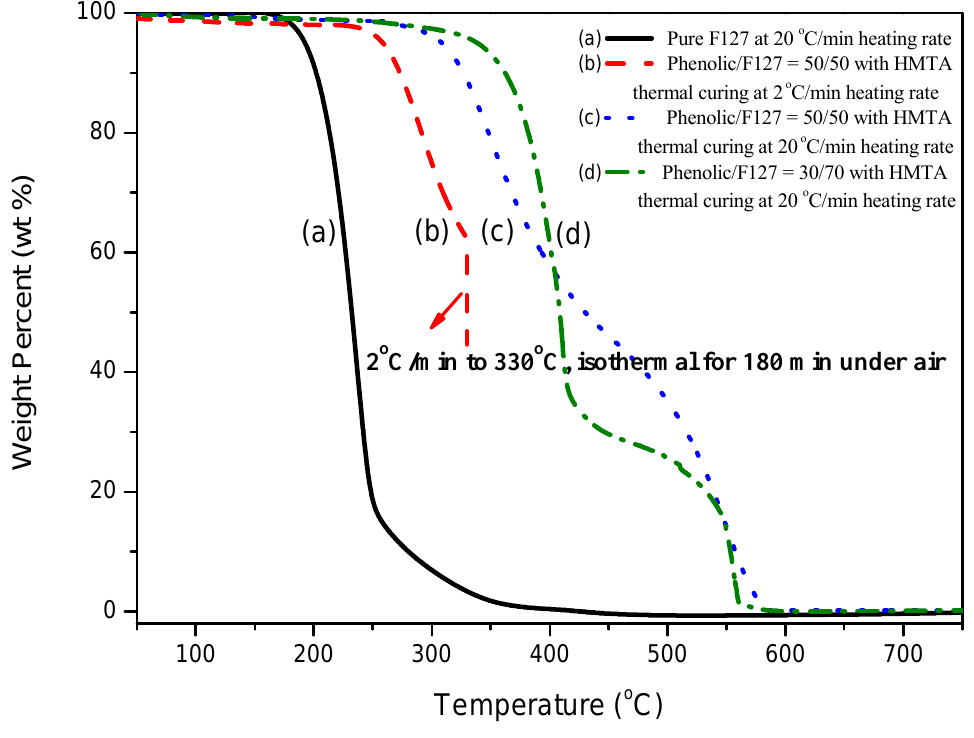
Figure 5. TGA analyses of ( a ) the pure triblock copolymer, F127, at a heating rate of 20 °C/min; ( b ) phenolic/F127 = 50/50 with HMTA thermal curing at a heating rate of 2 °C/min and after isothermal treatment for 3 h; ( c ) phenolic/F127 = 50/50 with HMTA thermal curing at a heating rate of 20 °C/min; and ( d ) phenolic/F127 = 30/70 with HMTA thermal curing at a heating rate of 20